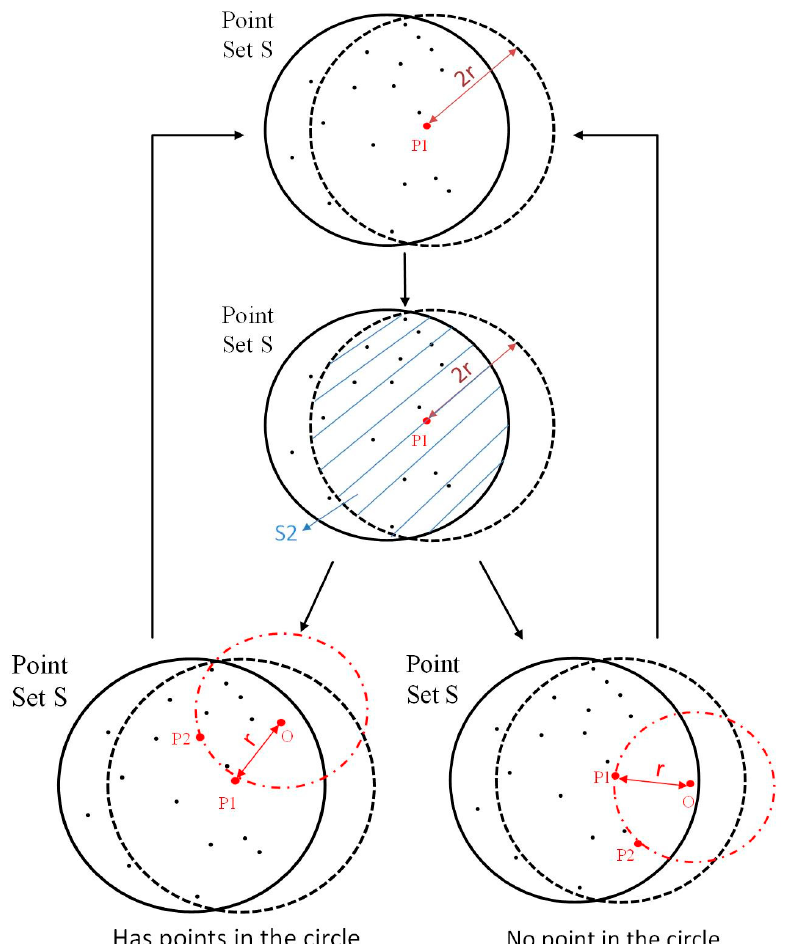
Figure 6. The boundary detection algorithm process.